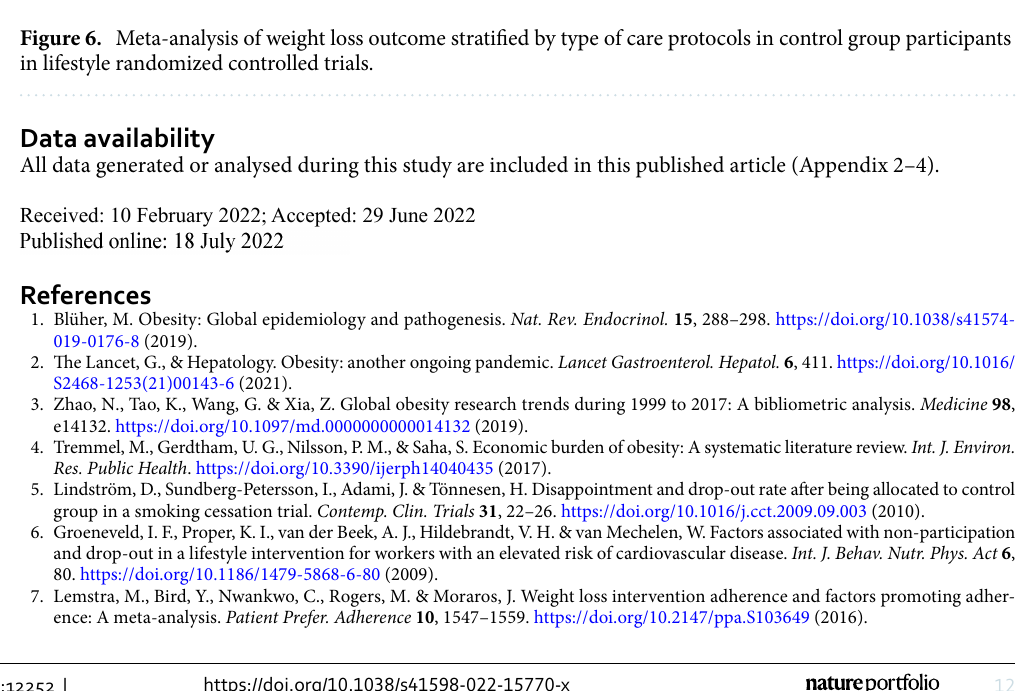
Figure 6. Meta-analysis of weight loss outcome stratified by type of care protocols in control group participants in lifestyle randomized controlled